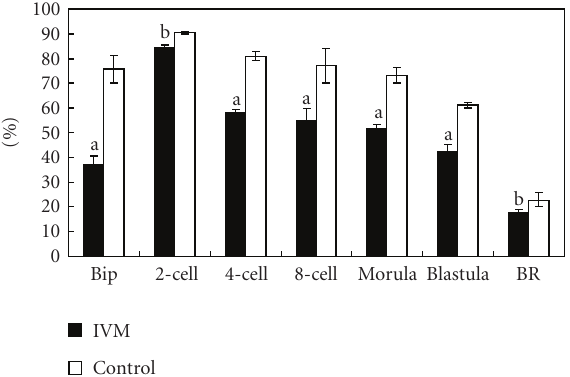
Figure 1: Rates of fertilization, cleavage, developmental compe- tence, and birth. Bip: Bipronucleus; BR: total number of born mice/total number of 2-cell embryos for transplantation. (a) P < . 01; (b) P < . 05.